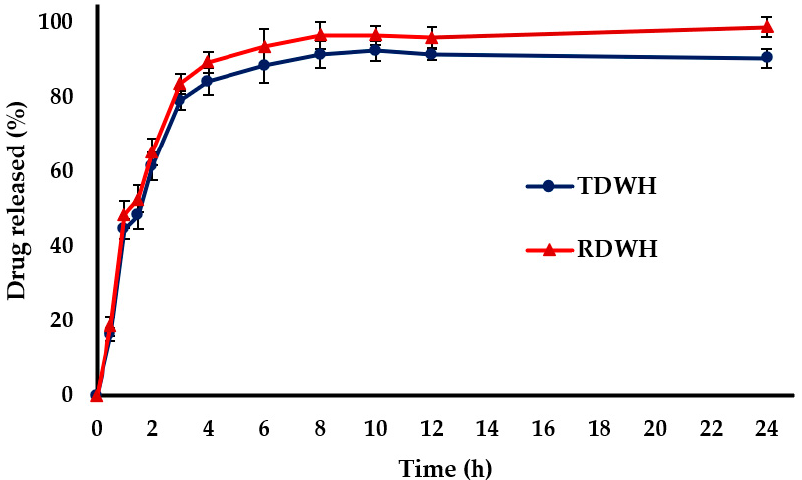
Figure 8. Comparative release profiles of RDWH gel (before storage) and TDWH gel (after storage).